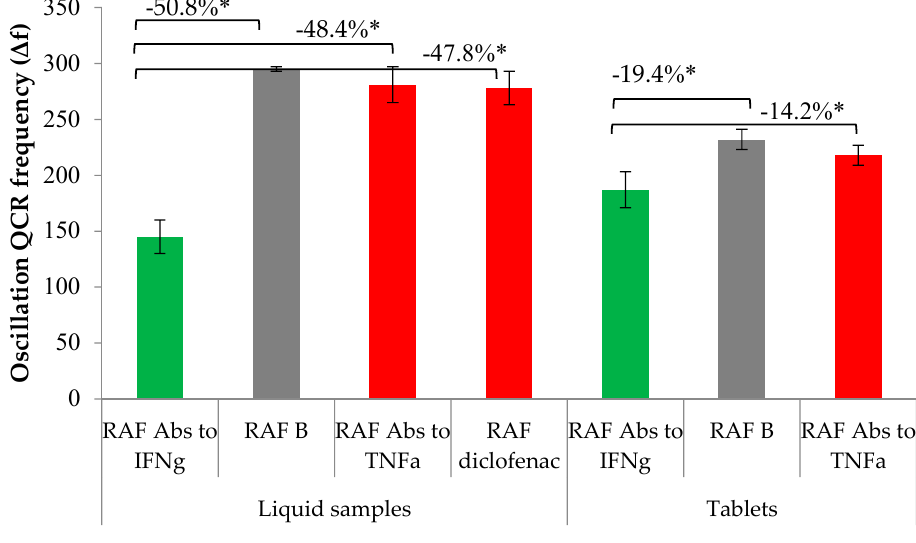
Figure 2. Specificity: analytical signals of test samples ( green ), controls ( grey ) and non-specific controls ( red ).